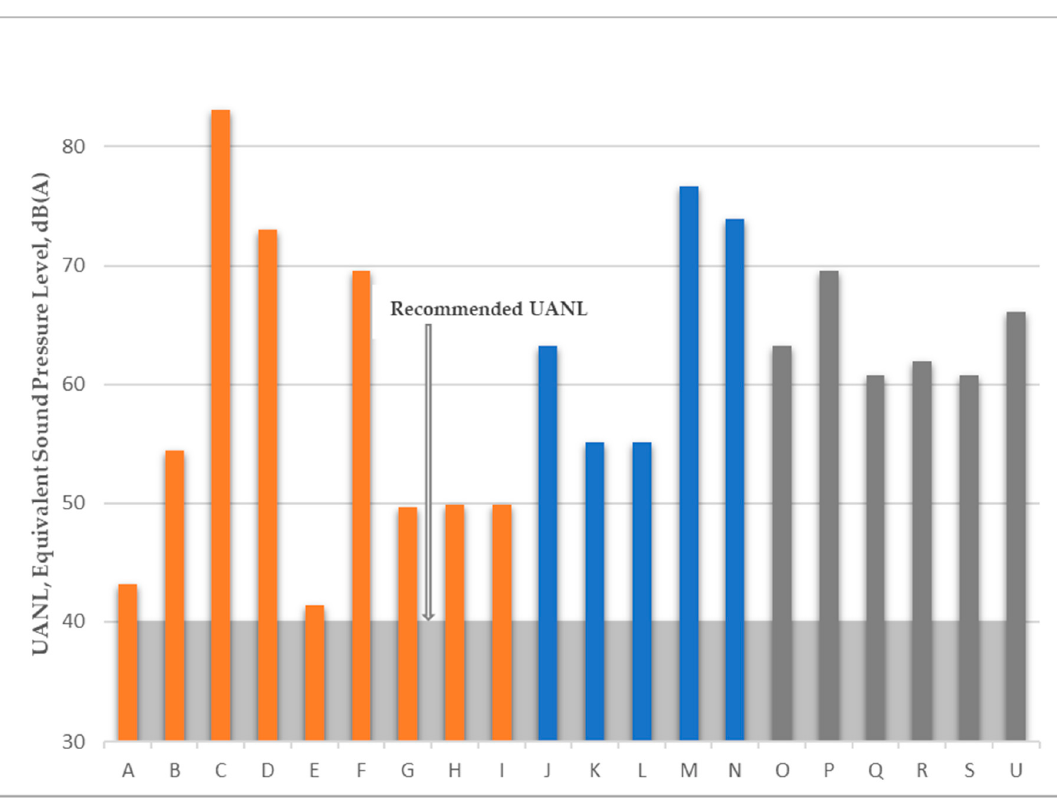
Figure 4. Unoccupied ambient noise level (UANL) equivalent sound pressure level L A,eq dB(A) at unoccupied indoor sports and gymnasium halls. Orange bars represent Category I, blue bars represent Category II, and grey bars represent Category III.